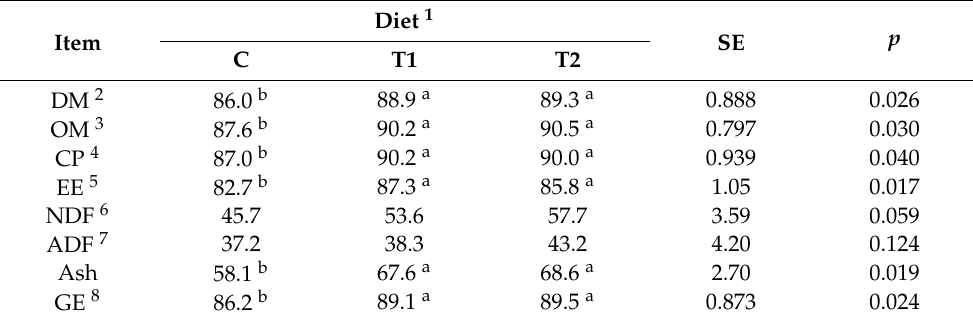
Table 6. Apparent fecal digestibility (%) in growing pigs (BW of 74.6 kg, on average) ( n = 18, six pigs per